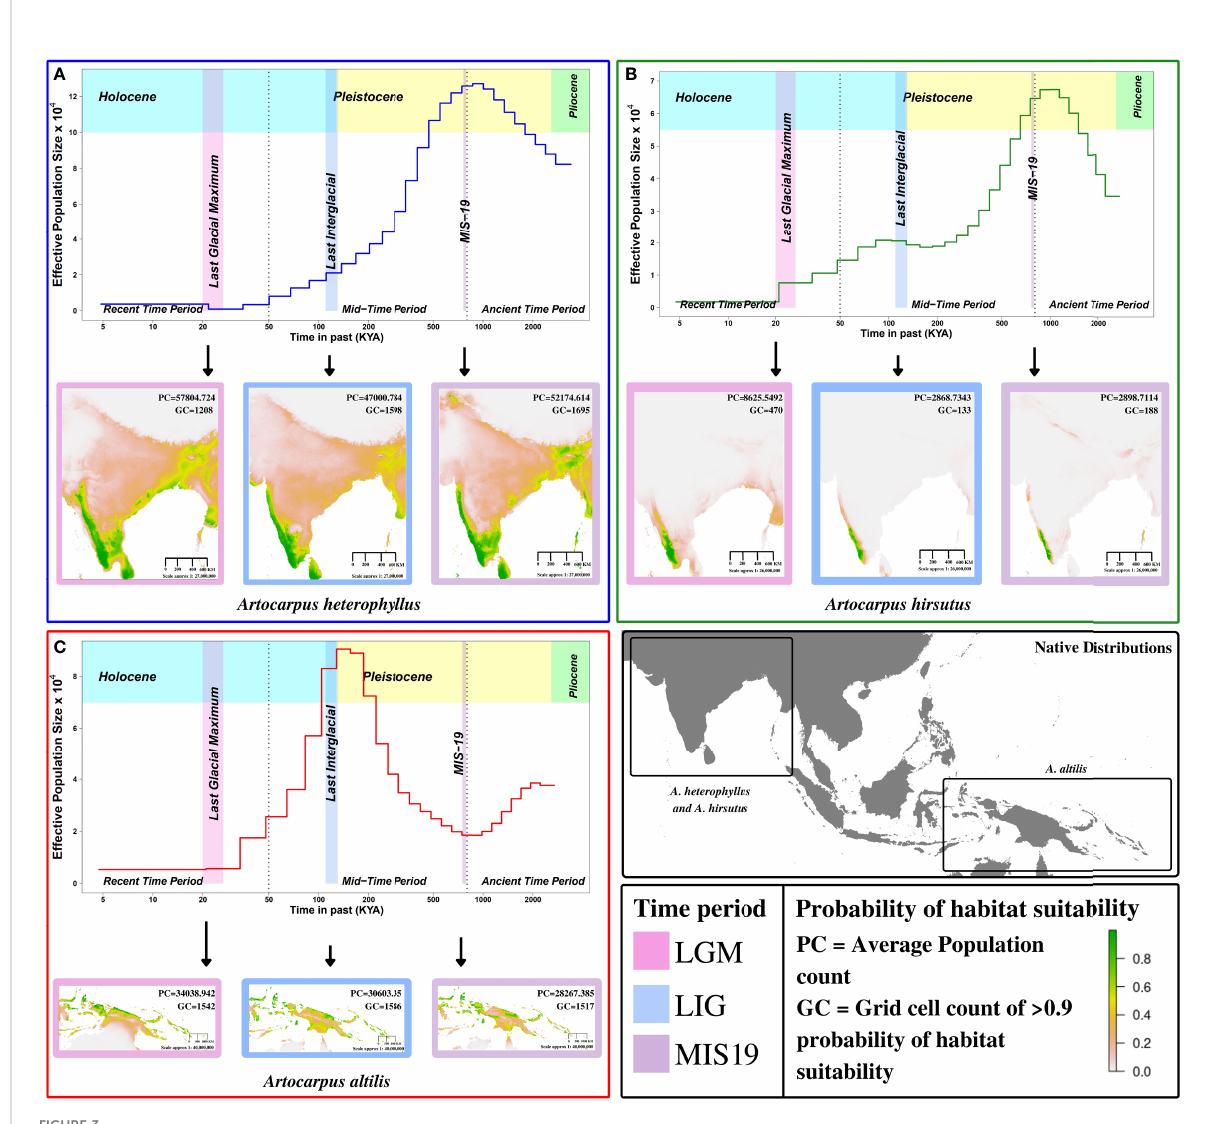
FIGURE 3 Demographic history reconstruction and species distribution modelling of Artocarpus species. Demographic history reconstruction using PSMC with Species distribution modelling for LGM (Last Glacial Maximum), LIG (Last Interglacial), and MIS19 (Marine Isotope Stage 19) for (A) A. heterophyllus (blue), (B) A. hirsutus (green), (C) A. altilis (red). The two dotted vertical lines are used to demarcate the recent, mid and ancient time periods following the timeline shown. The native distribution of all three species are highlighted in the bottom right map of the